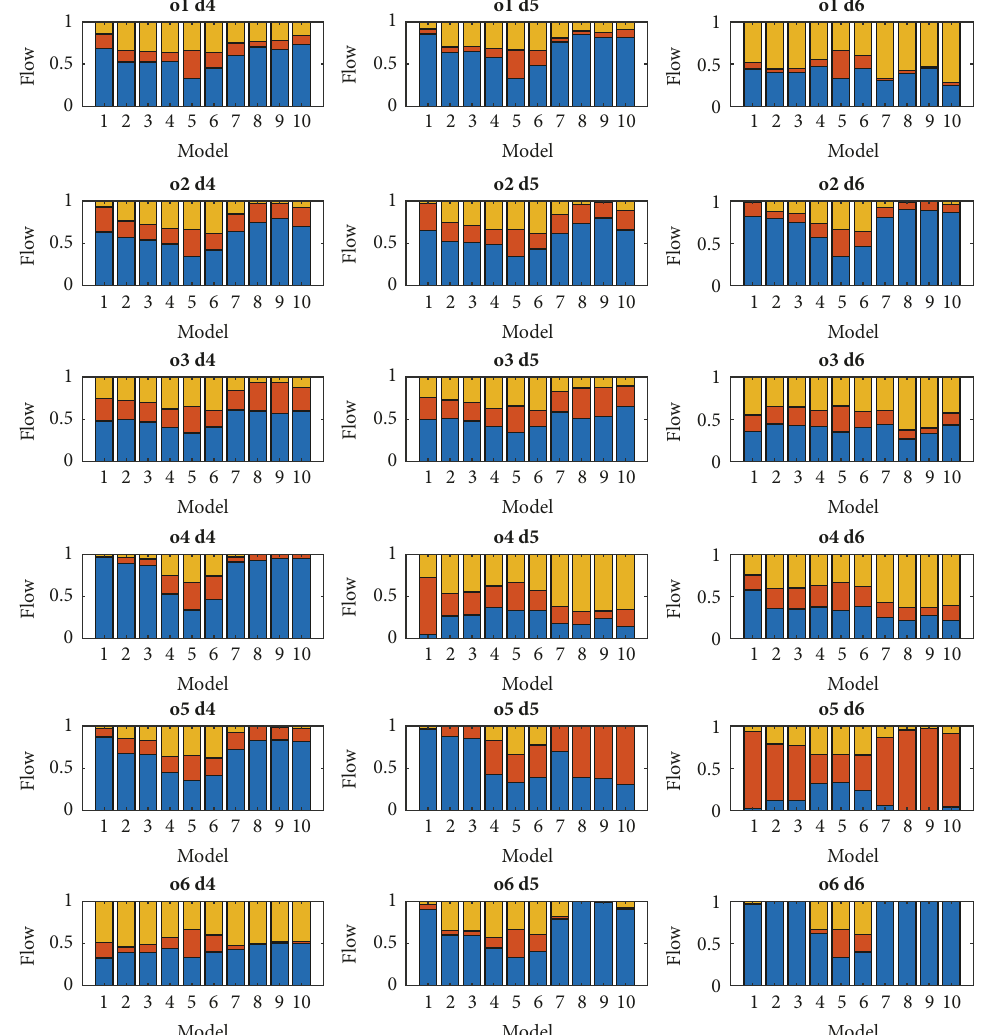
Figure 5: Same as in Figure 4, but for the od pairs: 𝑜 = 1, .. ., 6 and 𝑑 = 4,5,6